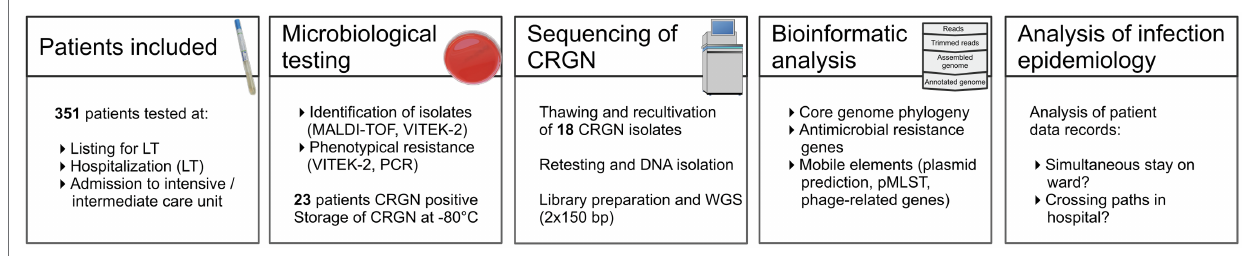
FIGURE 1 | Workflow of sampling, clinical microbiology, sequencing, and data analysis.